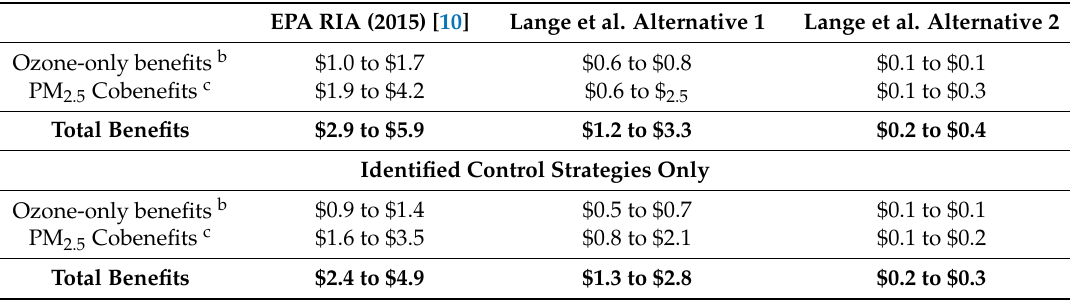
Table 6. Estimated Monetized Ozone and PM 2.5 Benefits for Revised and Alternative Annual Ozone Standards of 0.070 ppm using the EPA Final Ozone RIA [10] Table 6–24 as the basis (in billions of dollars) a .